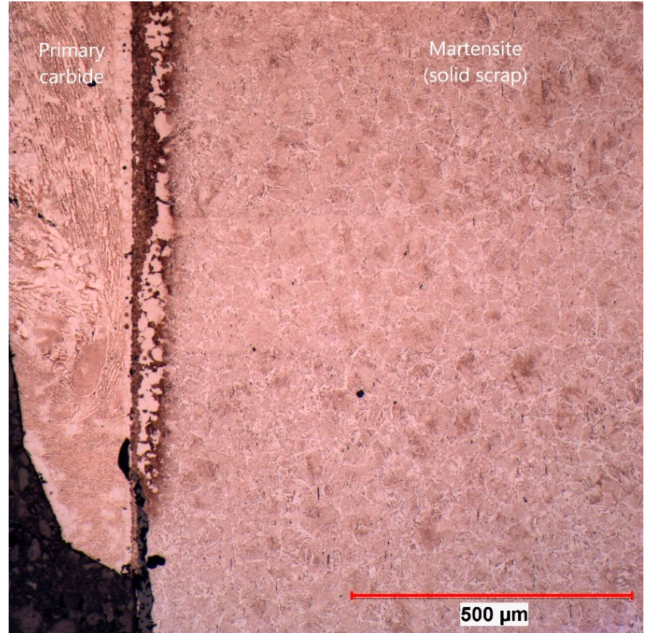
Figure 7. Section where the electron probe microanalysis (EPMA) measurement was carried out for sample 162 (20 s immersion time at 1230 ◦ C equilibrium temperature).